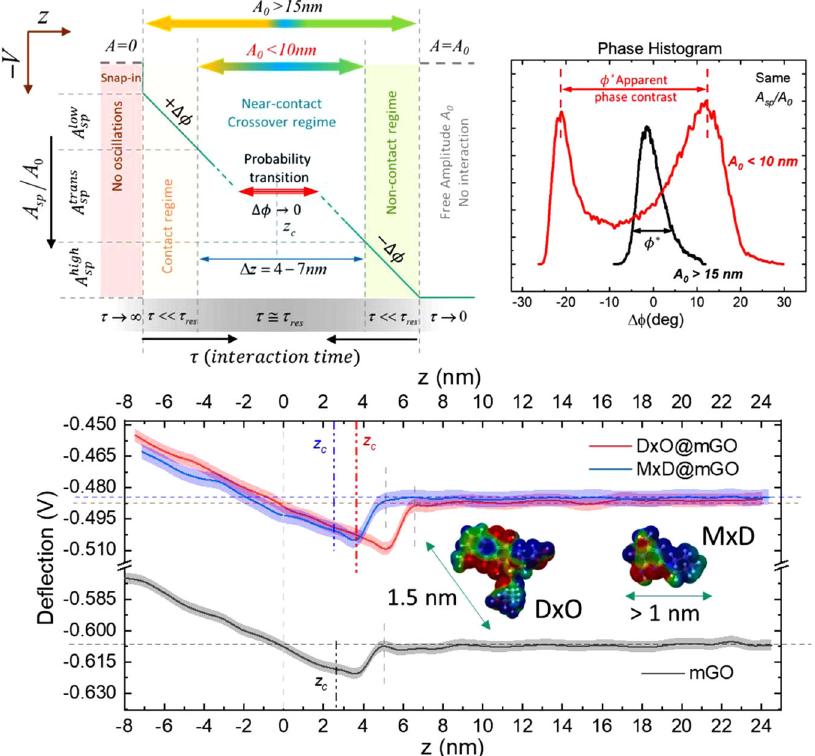
Fig. 1 Experimental schematic. The exploitation of fl uctuations in the near-contact crossover regime at tip – surface separations z c = 2.5 – 3.5 nm with ultra- light tapping amplitude ( A < 3 nm). Free amplitude A 0 and setpoint amplitude A sp are judiciously optimized. The dynamic response of interaction with soft drug clusters leads to a two-stage distribution in phase giving an apparent phase contrast ϕ (cid:1) . DxO@mGO and MxD@mGO represent Doxorubicin and Minoxidil clusters on multilayered graphene oxide (mGO)